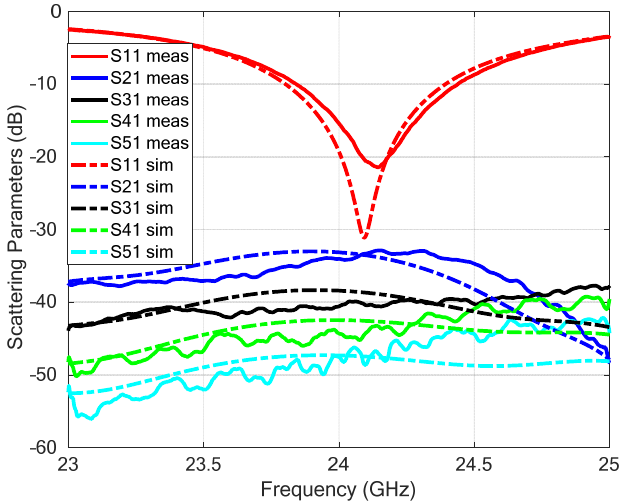
Figure 6. Measured (meas) and simulated (sim) scattering parameters of the array antenna system. The ADSimPLL software [37] was used to design the chirp shape and the loop fi lter components. The PLL parameters (maximum, minimum, reference and phase detector